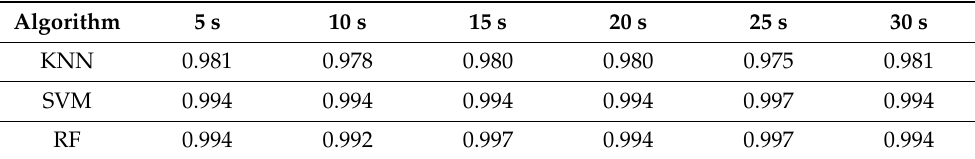
Table 8. Classification accuracy of SVM, RF, and KNN algorithm models using different slice time data of the cabin gas detection test.